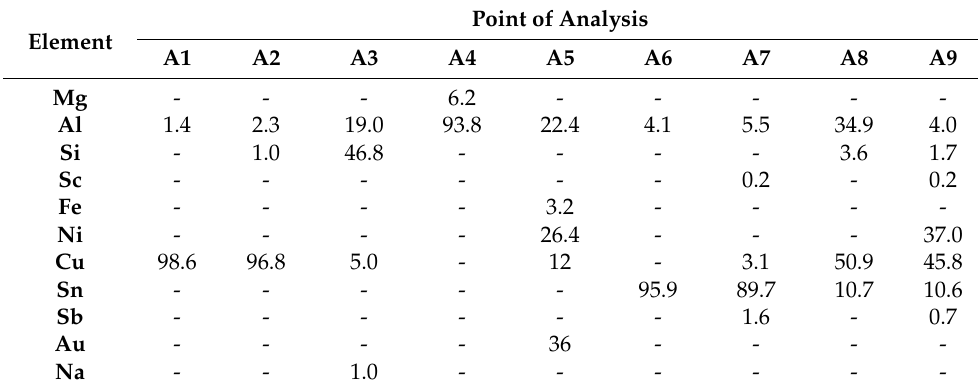
Table 4. Elemental concentrations (% at.) measured with EDS in the micro-areas marked in Figure